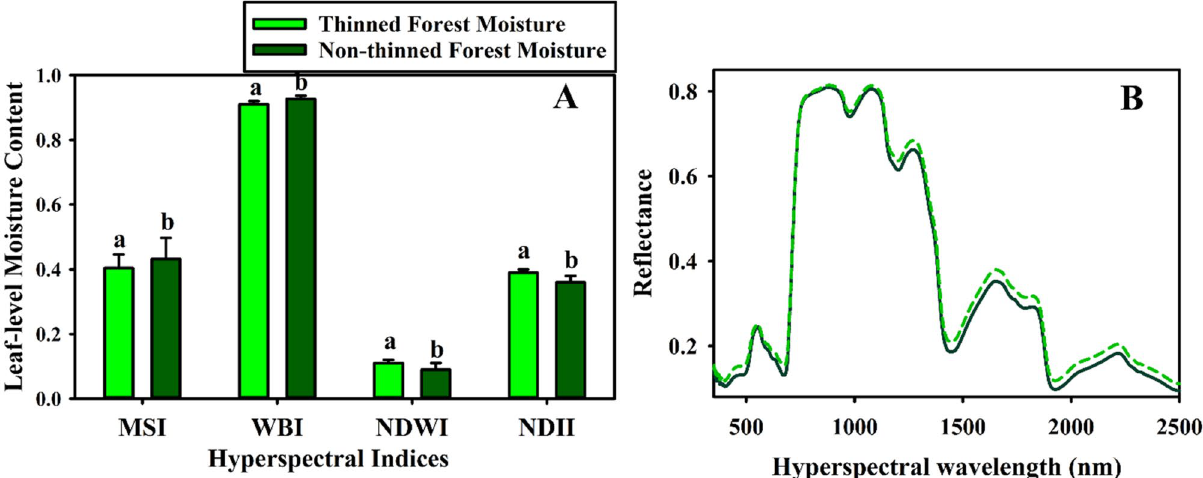
Figure 5. Hyperspectral indices of forest moisture content (Panel A ) and hyperspectral reflectance (Panel B ) from tree samples in thinned (N = 31) and non-thinned (N = 33) forests during 2021 drought year. The bars and whiskers indicate the mean values and standard errors for each index, respectively. The different letters (a versus b) within pairs of bars indicate statistically significant differences (p < 0.05). MSI and WBI are simple ratios, which increase with greater plant water stress. NDWI and NDII are normalized difference ratios that decrease as plant water content decreases. When compared with ANOVA tests, all four hyperspectral indices indicated that the non-thinned, dense forest trees have significantly lower plant water content (all p < 0.05) and are significantly more water-stressed compared to the thinned forest